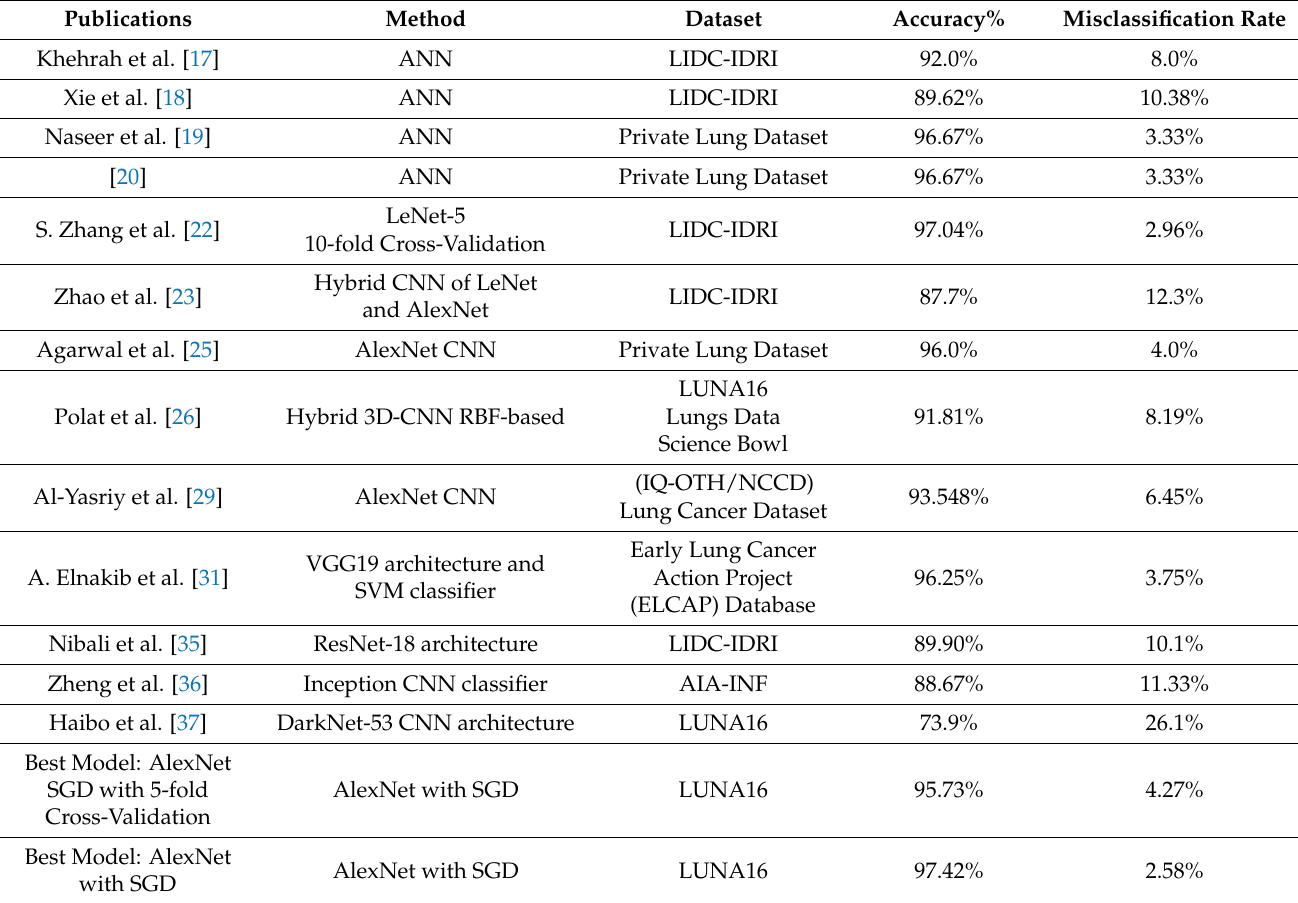
Table 14. Comparison of AlexNet with the SGD model with previously published